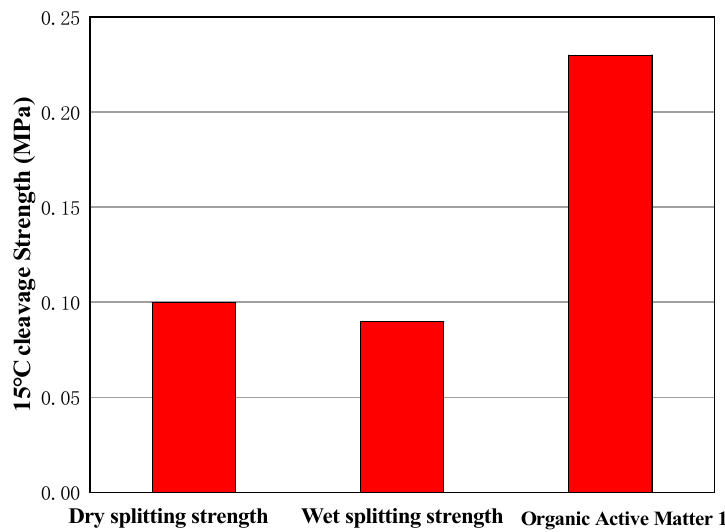
Figure 11. Comparison of strength by adding an organic activator.